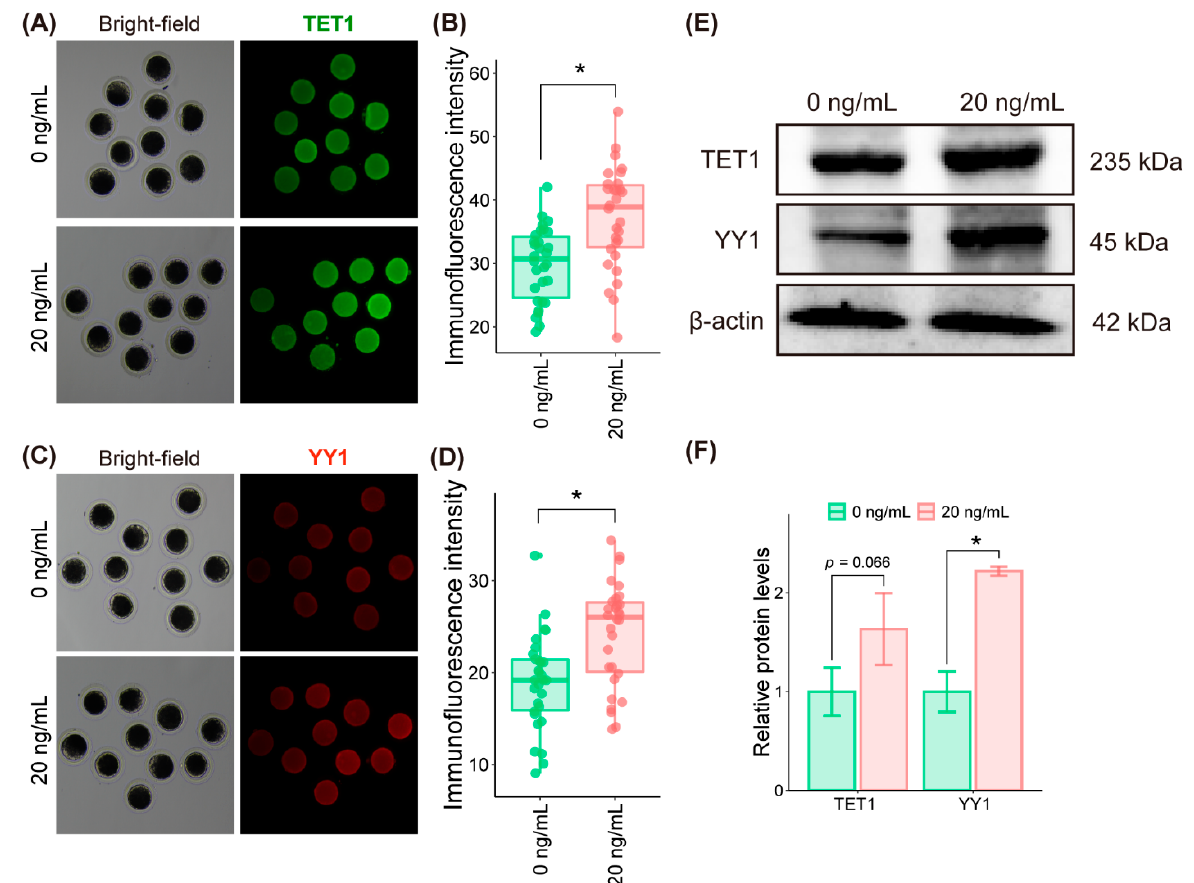
Figure 8. Comparison of TET1 and YY1 protein levels between the 20 ng/mL SDF1-treated and control porcine oocyte. Detection of TET1 ( A ) and YY1 ( C ) proteins in matured oocytes by immunoflu- orescence staining. Quantification of TET1 ( B ) and YY1 ( D ) proteins measured by immunofluores- cence staining. ( E ) Detection of TET1 and YY1 proteins in matured oocytes by western blotting. ( F ) Quantification of TET1 and YY1 proteins measured by western blotting. “*” represents p < 0.05.